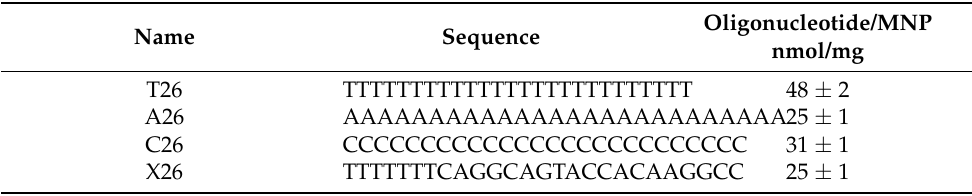
Table 2. The comparison of the MNP capacity using various oligonucleotide sequences in an aqueous